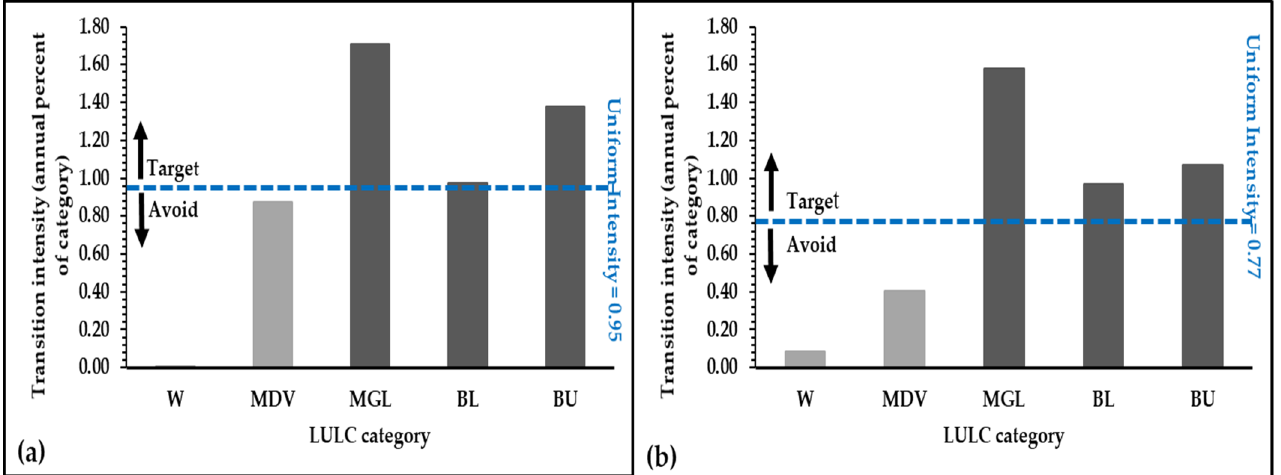
Figure 4. Intensity of gains and losses by category during ( a ) 1991–2007 and ( b ) 2007–2020 for the KLCRS.